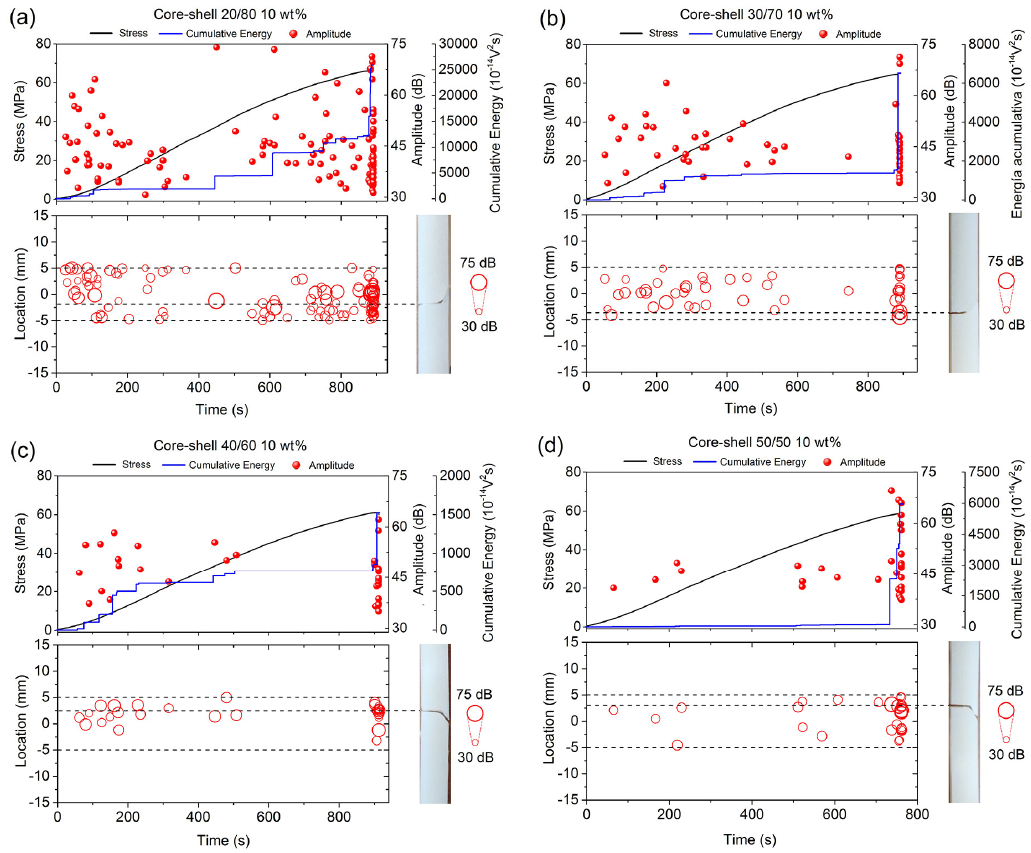
Figure 5. AE signals detected during the four-point bending test in correlation to their respective locations along the specimen surface in the bone cements containing 10 wt % of core-shell nanoparticles ( a ) 20/80, ( b ) 30/70, ( c ) 40/60, and ( d ) 50/50.